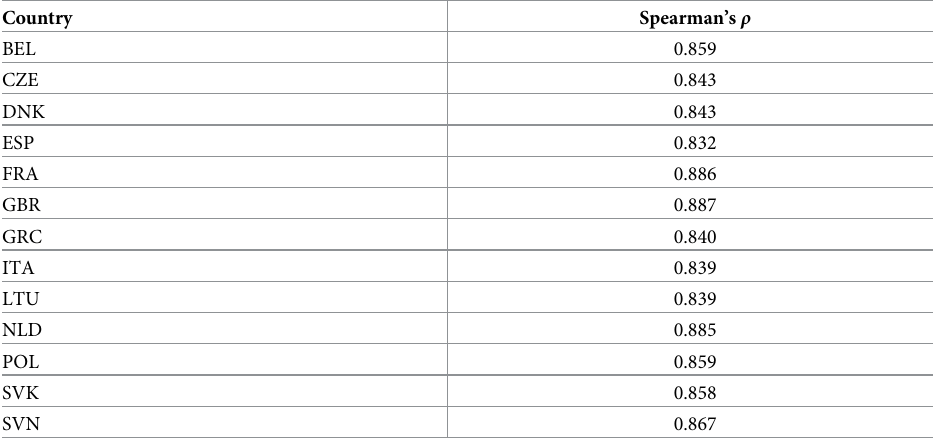
Table 7. Correlation between countries’ and the European DCI PIAAC.